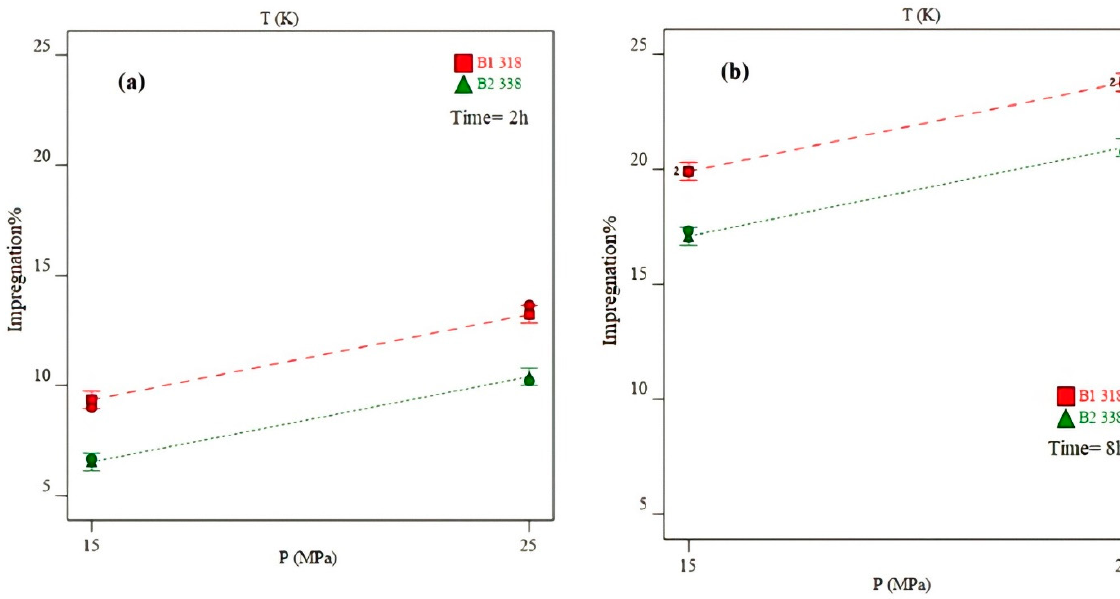
Figure 6. The plots to represent the effect of ( a ) the interaction of temperature and pressure with a time of 2 h, ( b ) the interaction of temperature and pressure with a time of 8 h, on the loading of EO in the PLA